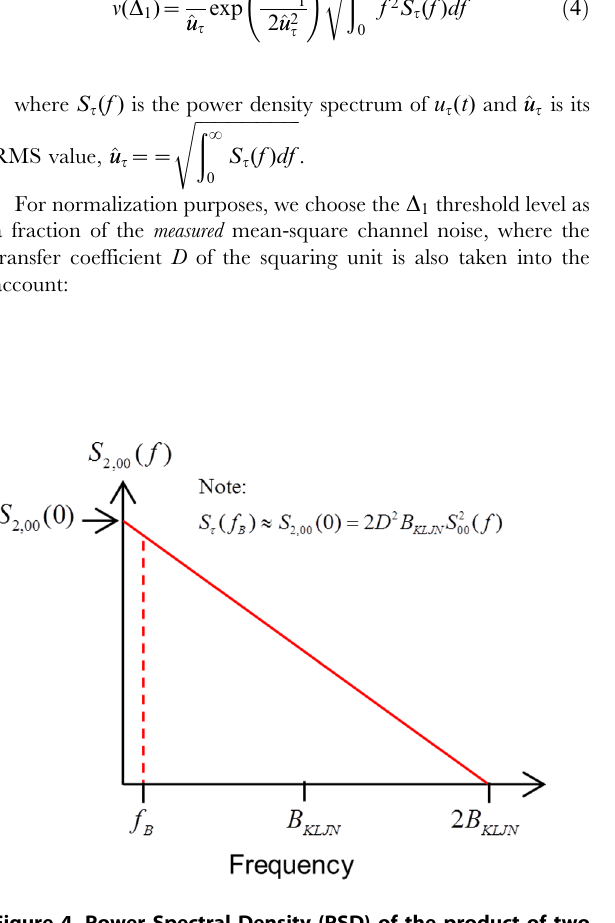
Figure 4. Power Spectral Density (PSD) of the product of two independent noises. S 2,00 ( f ) is the power density spectrum of the AC component u 2,00 ( t ) of the (non-averaged) u 2